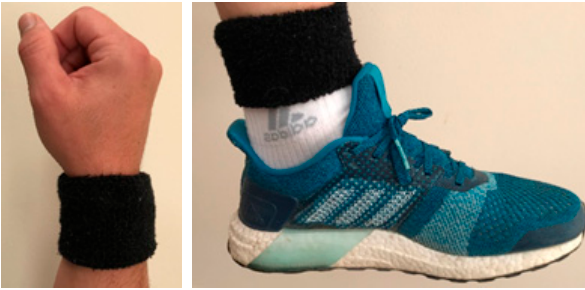
Figure 2. Positioning of the sensors.